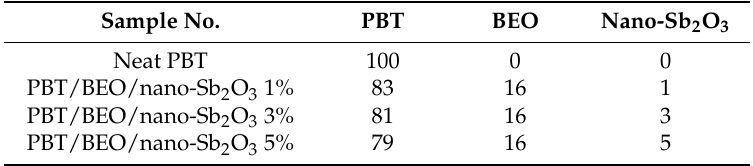
Table 1. Composition of the formulations (wt %). BEO, brominated epoxy resin. Sample